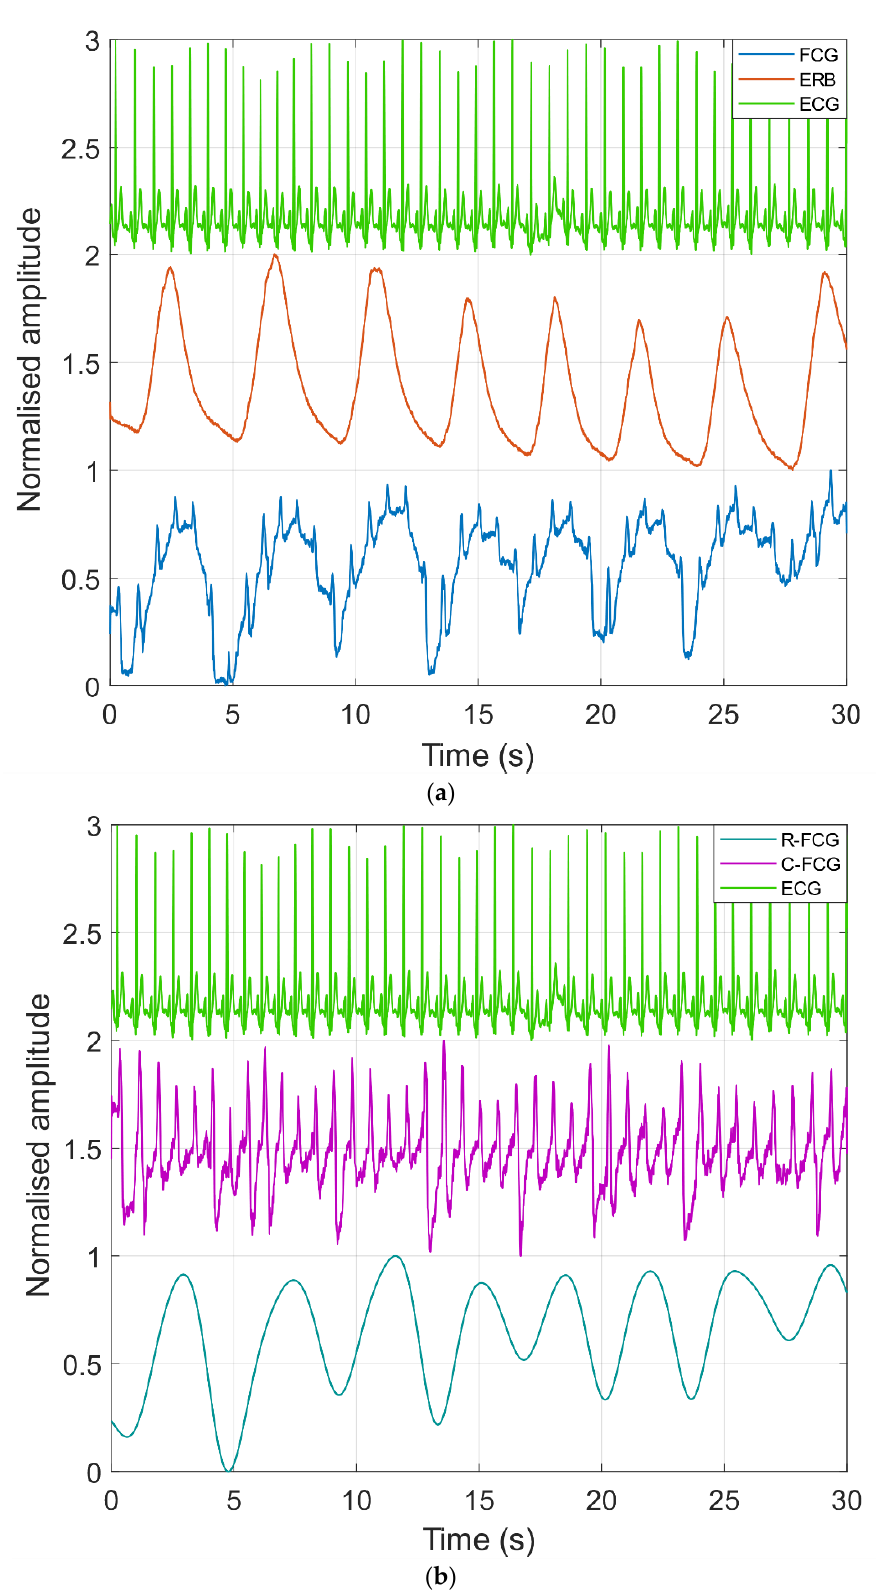
Figure 4. ( a ) An excerpt of raw FCG, ERB and ECG signals acquired from subject #7; ( b ) respiratory (R-FCG) and cardiac (C-FCG) components extracted from FCG signal depicted in panel ( a ).